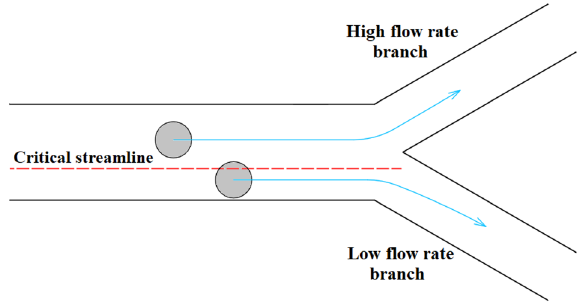
Figure 1. Effect of bifurcation region on separation of particles. Particles placed above the critical streamline are drawn into the high-flow-rate branch while those located under the critical streamline are conducted to the low-flow-rate